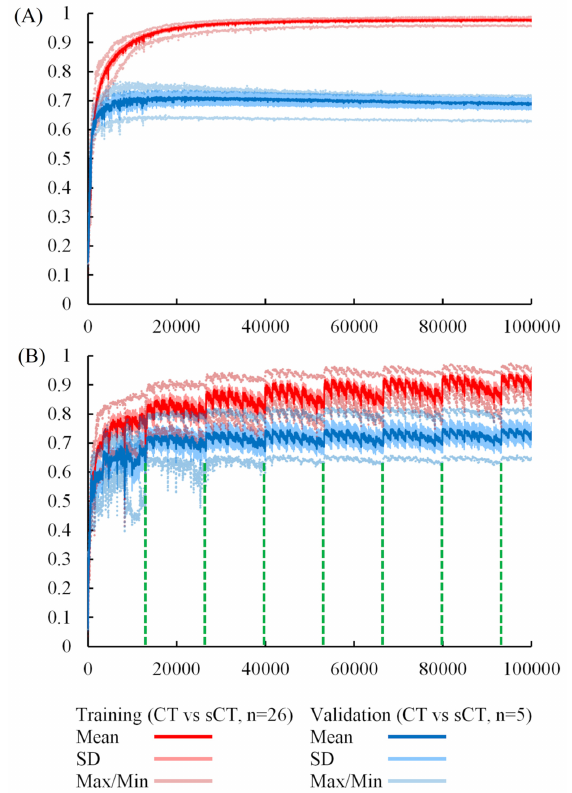
Figure 8. The MSSIM of training process. ( A , B ) show the results of Experiment 1 and Experiment 2, respectively. The performance of the p3_k4_f80 model is validated with original training data ( n = 26) and testing data ( n = 5) after 26 iterations. One epoch equivalent to 26 iterations and the period of data augmentation is 13,312 iterations (26 × 512). The data augmentation cycles end at iterations 13,312; 26,624; 39,936; 53,248; 66,560; 79,872; and 93,184. “SD” is the abbreviation for “standard deviation”. 4.3. The Approach Is Extendable for Higher-Resolution Datasets In this paper, we obtain five patched datasets from the original dataset wherein each image has a very high number of voxels. It is impossible to create a model to manage our original dataset directly, and the number of trainable parameters is too numerous to be affordable for hardware. Compared to the original dataset, the benefit of a patched dataset